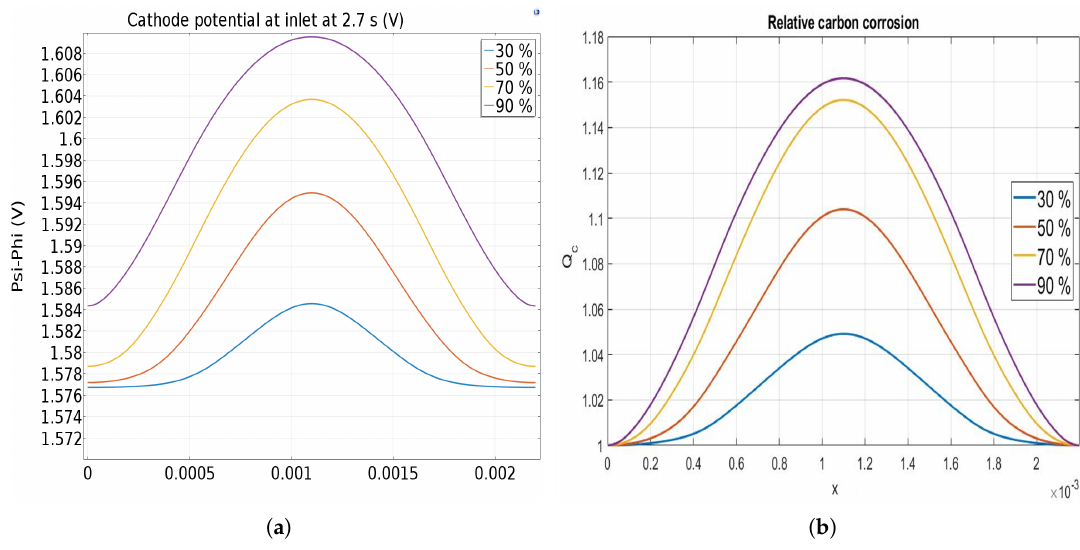
Figure 9. Cathode potential ( a ) and relative carbon corrosion ( b ) at 2.7 s for different designs. The figures are centered on the